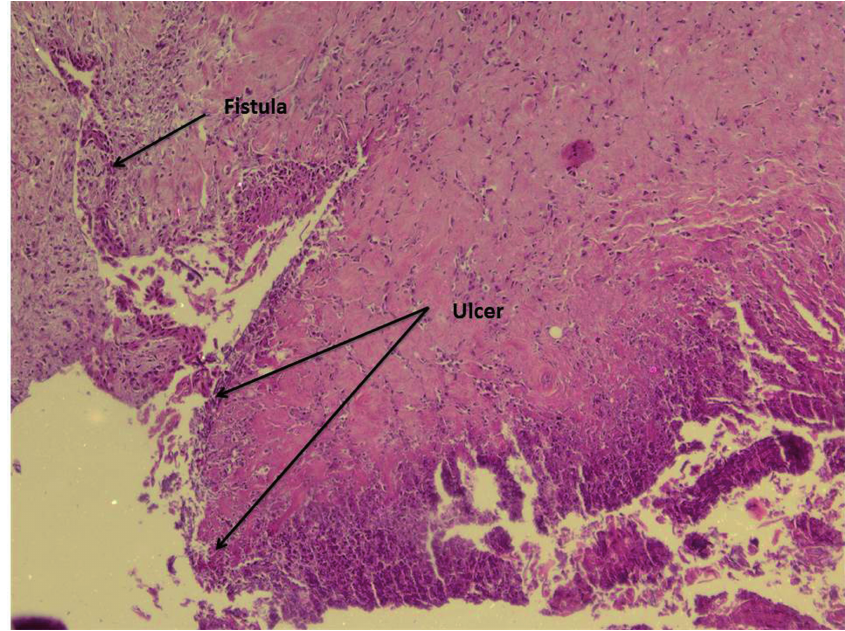
figure 3 - histological representation of epithelial erosion and presence of necrotic tissue in the luminal area of the urethra (group 2 weeks, hE x